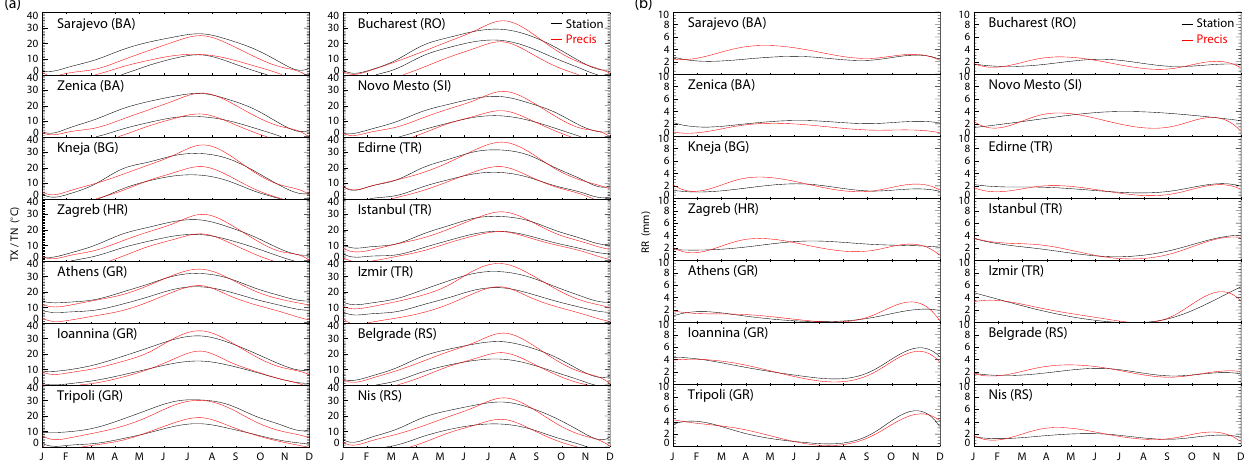
Figure 1. Temperature (1st and 2nd panels) and precipitation (3rd and 4th panels) annual cycle at 14 examined stations, as represented by station (black line) and model (red line) data. In temperature diagrams, the upper (lower) pair of lines represent maximum (minimum)